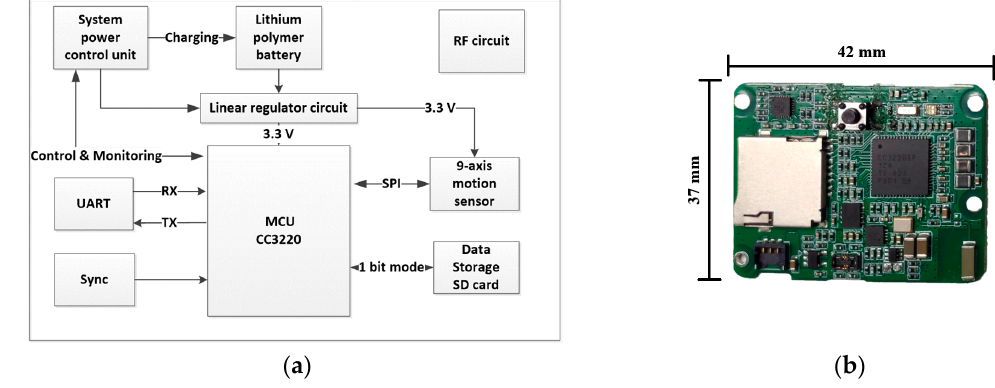
Figure 2. ( a ) Hardware diagram of the motion sensor. ( b ) The motion sensor.